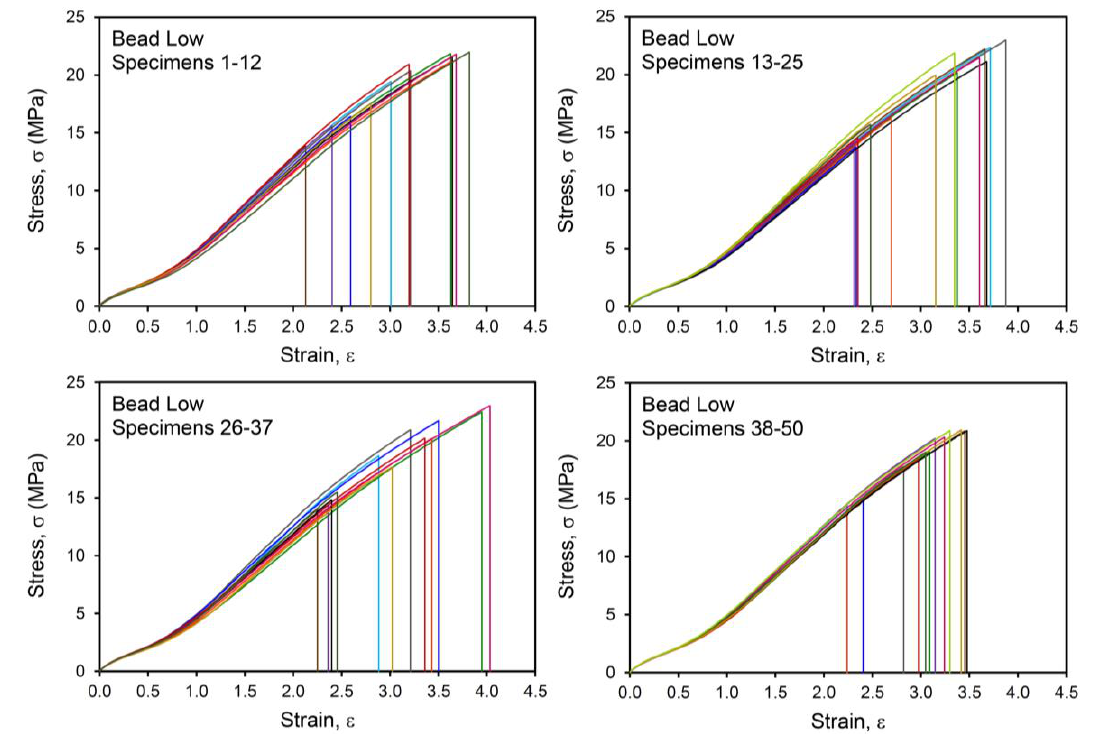
Figure 4. Tensile stress–strain results up to break for Bead Low compound, with data for 50 specimens (replicates) shown using different colored lines.